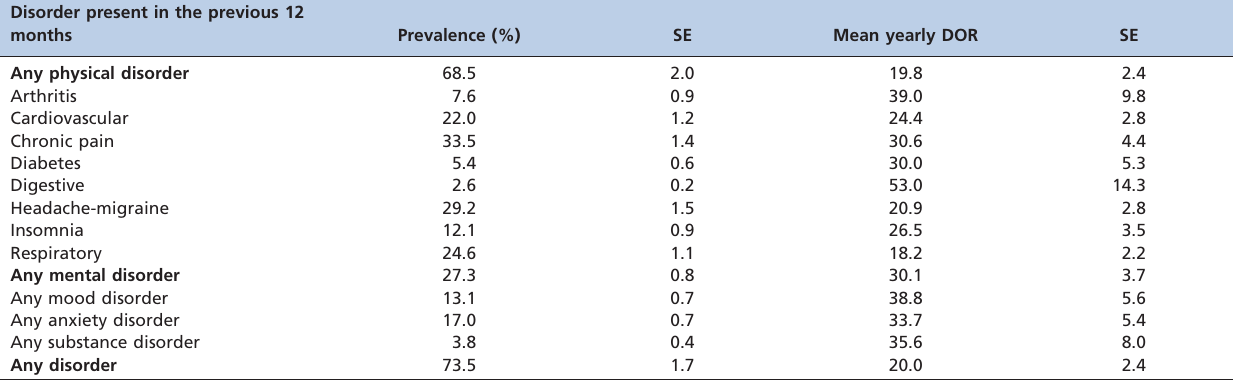
Table 3 - Twelve-month prevalence of the disorders investigated and the mean number of days completely out-of-role per year. The Sa˜o Paulo Megacity Mental Health Survey (n=